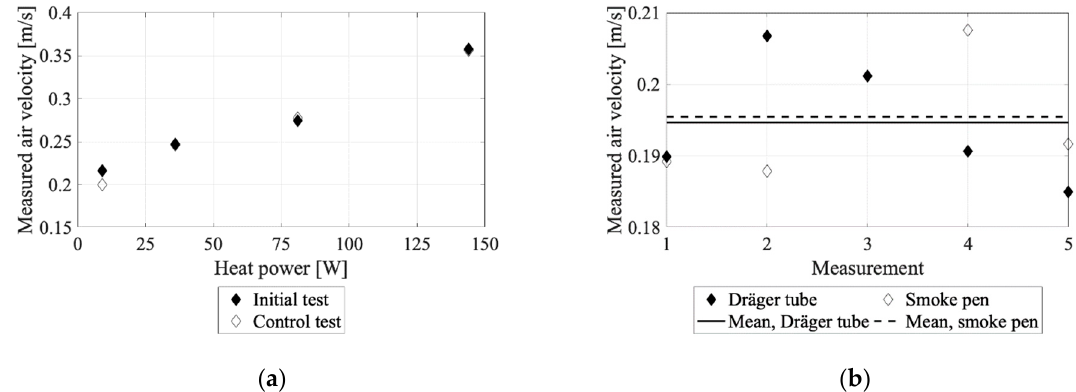
Figure 3. ( a ) Validation of the experimental method, presented as a comparison of measured air velocity in initial test run and a control test run for test setup h = 48 mm, θ = 15 ◦ ; ( b ) Comparison of methods utilized for smoke production, at test setup h = 48 mm, θ = 15 ◦ . The mean is calculated as the average of the five measurements.